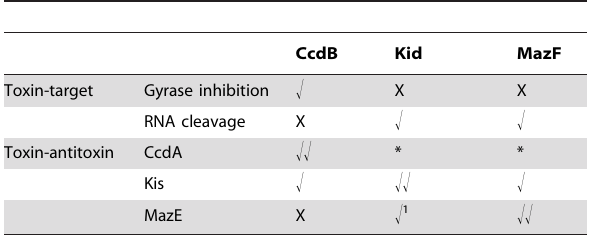
Table 2. ccd and parD toxin-target and toxin-antitoxin